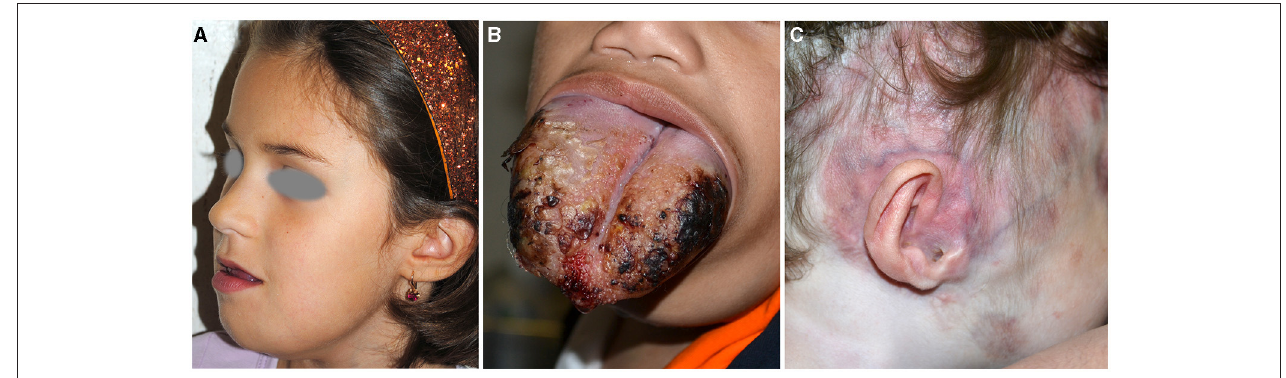
FIGURE 5 | Microcystic lymphangioma involving the tongue, the submandibular area, and the chin causing macroglossia, deformity, and sialorrhoea (A) . Microcystic lymphangioma of the tongue in an 18-month-old patient treated with tracheostomy and percutaneous endoscopic gastrostomy for dysphagia and respiratory distress (B) . CM and deformity of the auriculotemporal area due to osteolysis in a child affected with Gorham–Stout disease (C) .